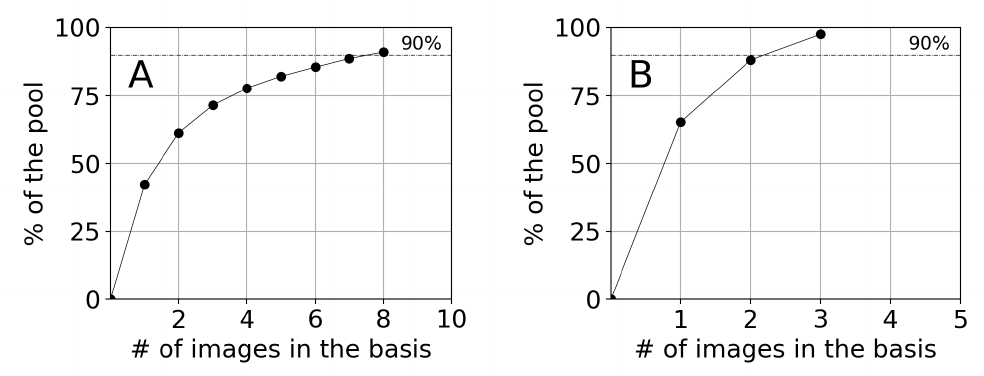
Figure 7. Percentage of images of the pool with n p = 4 (or more) cells having pairs with the basis as new images are incorporated to it: BCN1 ( A ) and BCN2 ( B ).